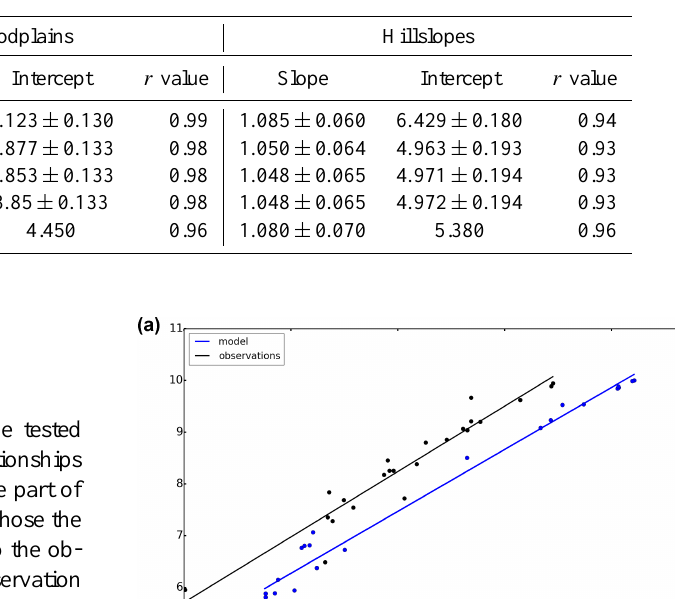
Table 2. Summary of regression results of the scaling of sediment storage at the end of the equilibrium and transient simulations. Here we consider only the grid cells that correspond to the observation points from Hoffmann et al. (2013) and fall into the borders of the Rhine catchment. The r value is the Pearson correlation coefficient, and the slope and intercept are the scaling parameters.